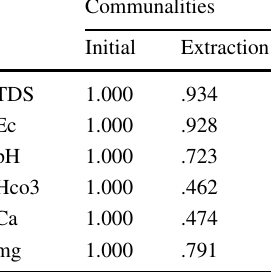
** Correlation is significant at the .01 level